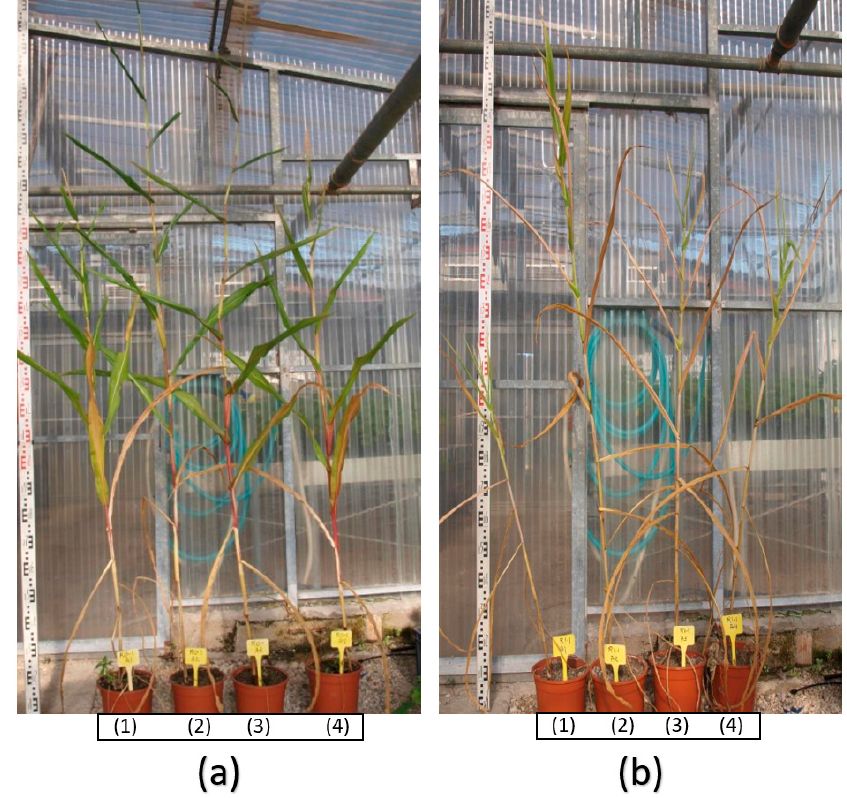
Figure 4. Phenotype registered in maize plants under capsuled-seed treatment in greenhouse tests. ( a , b ) These pictures show the 120 DAT phenotype of seedlings treated with capsuled xerotolerant strains under regular ( a ) and drought ( b ) conditions, both in pots and in full-plant view. Applied treatments were: (1) mock, (2) Microbacterium sp. 31J, (3) A. koreensis 5J12A and (4) P. putida KT2440. Three repetitions od three replica ( n = 9) were prepared for this test. In the scale bars, each section corresponds to a 10-cm reference.